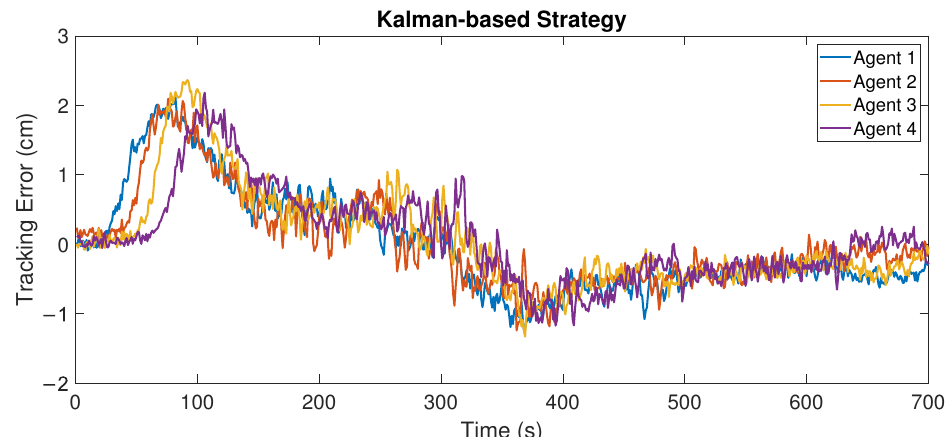
Figure 25. Mean ¯ ζ i ( k ) of 8 trials of the tracking error using the Kalman-based strategy with a moving platoon.